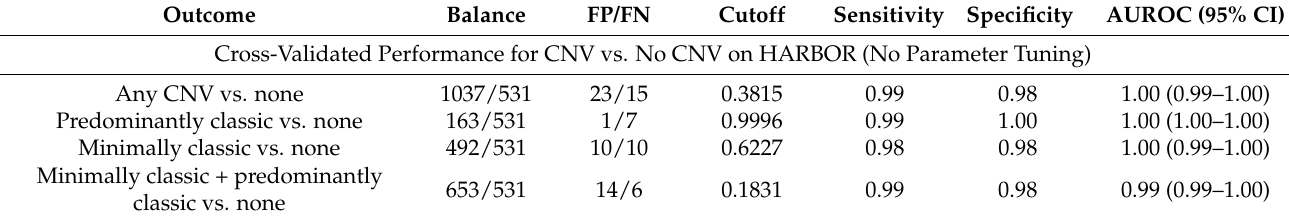
Table 3. Diagnostic Accuracy of the Algorithm in Detecting FA-Defined CNV Phenotype on SD-OCT; Cross-validation results report best-tuned performance across the parameter grid. External validation reports unbiased performance against hold-out data. Outcome Balance FP/FN Cutoff Sensitivity Specificity AUROC (95% CI) Cross-Validated Performance for CNV vs. No CNV on HARBOR (No Parameter Tuning) Any CNV vs. none